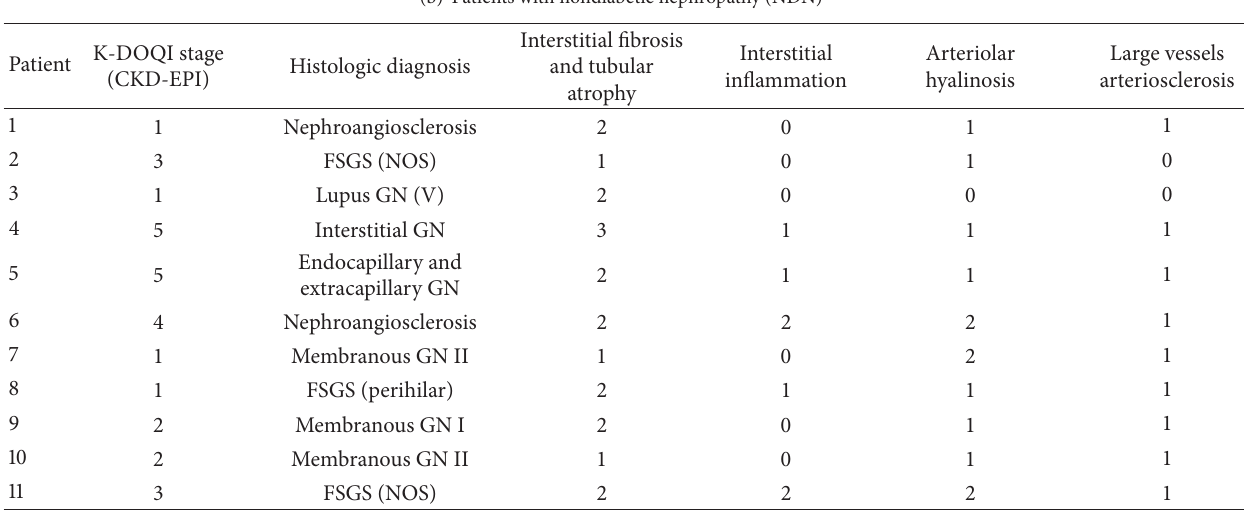
(b) Patients with nondiabetic nephropathy (NDN)